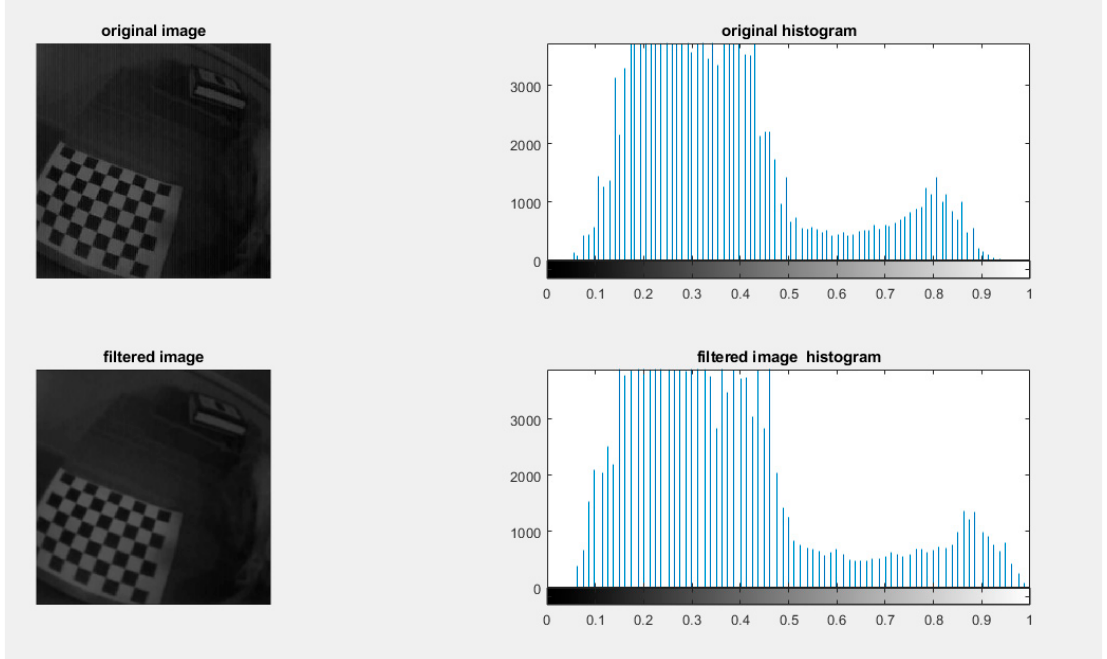
Figure 11. Comparison between the original image and filtered Image .